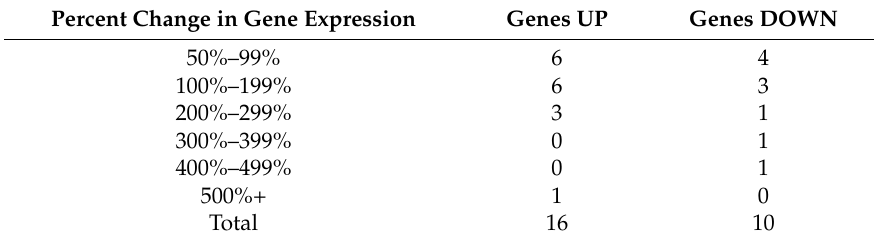
Table 25. Distribution of Genes Affected by GHK and Associated with Oligodendrocytes. Percent Change in Gene